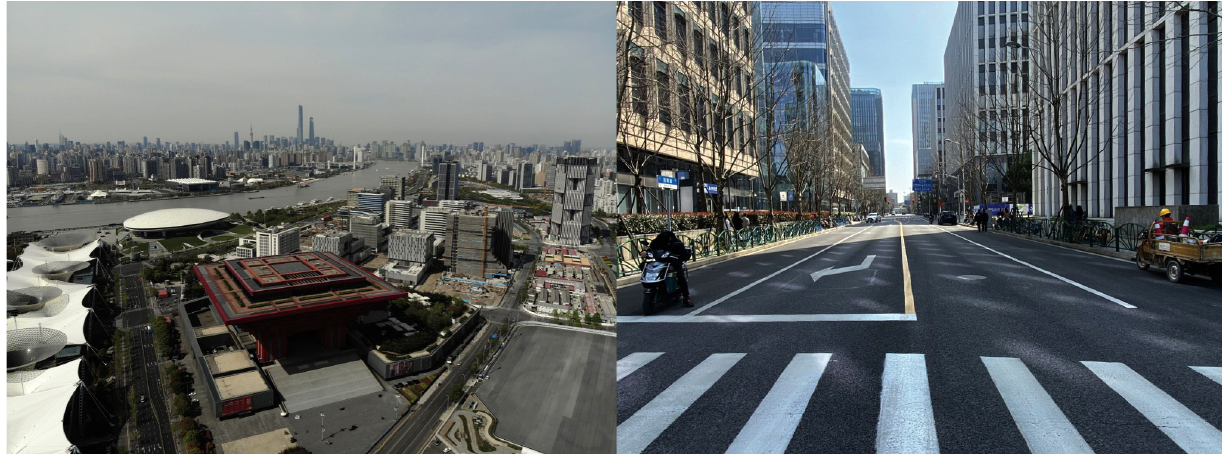
Figure 2. Two pictures of the former expo area filled with grade‐A offices around remaining expo‐pavilions. Source: Author (Summer 2020).